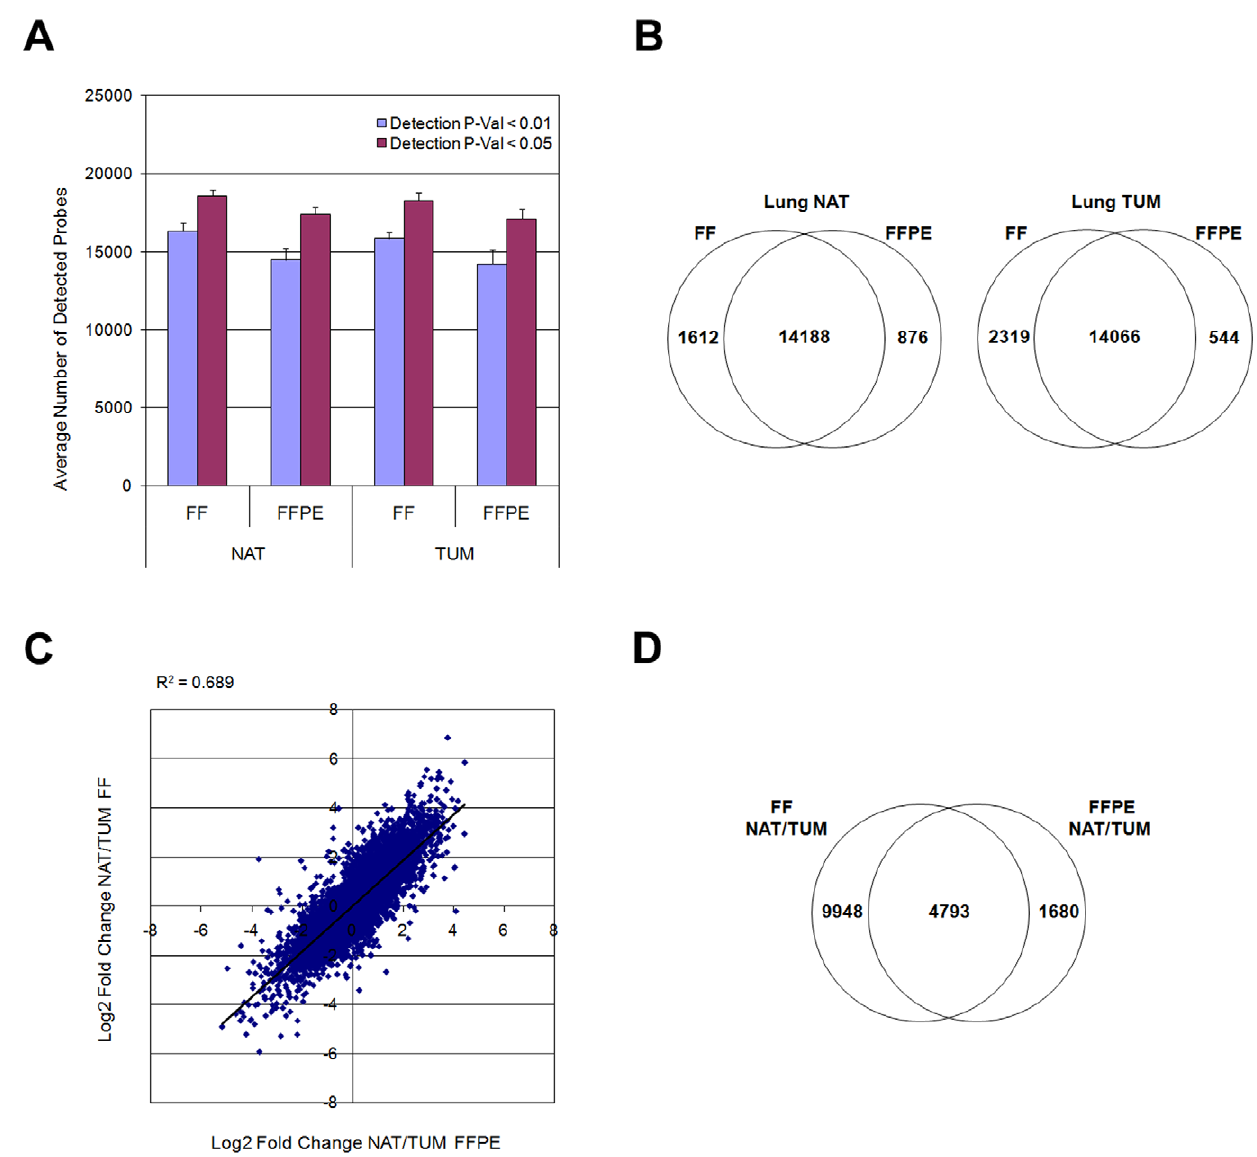
Figure 2. Comparison between fresh-frozen (FF) and FFPE samples. Matched FF and FFPE samples for lung tumor (TUM) and normal adjacent tissue (NAT) were labeled and hybridized using the WG-DASL assay. (A) Assays were performed in quadruplicate and the average number of detected probes plotted for each sample (error bars 6 SEM). (B) The overlap of detected probes between the matched FF and FFPE samples for both the NAT and TUM tissues was calculated as the percentage of detected FFPE probes also detected in the corresponding FF sample. (C) The fold- change correlation between FF and FFPE samples was calculated as the Log 2 of the fold-change between the NAT and TUM tissues intensities. All detected probes (Detection p-value , 0.01) are plotted. (D) Lists of differentially expressed probes were generated by comparing replicates of the NAT and TUM tissues with a false discovery rate (FDR) cutoff of , 5%. The overlap of differentially expressed probes between the FF and FFPE matched samples for both the NAT and TUM tissues was calculated as the percentage of differentially expressed FFPE probes also detected in the corresponding FF sample.